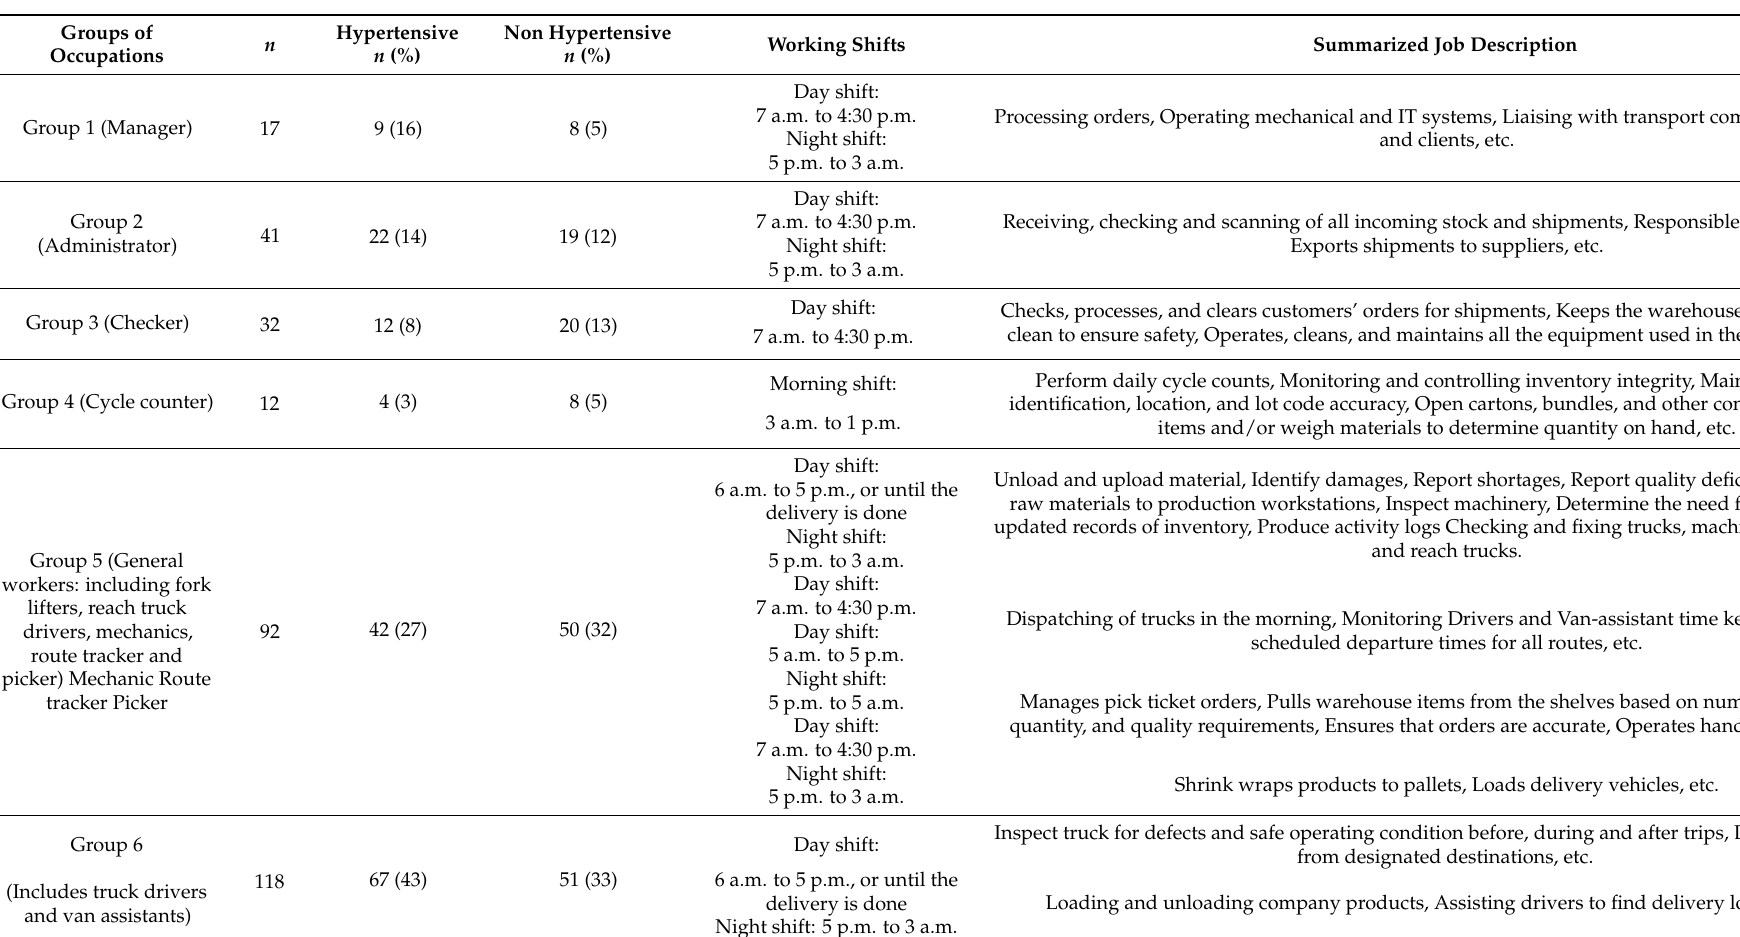
Table 3. Occupation profile of